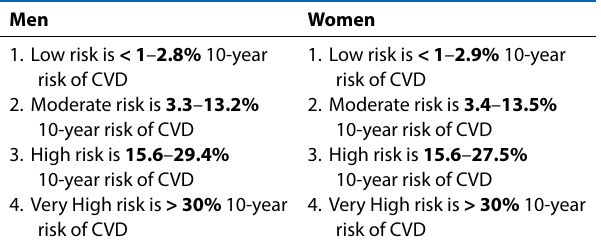
Table 9: Risk grading for 10-year risk of CVD based on sex Men